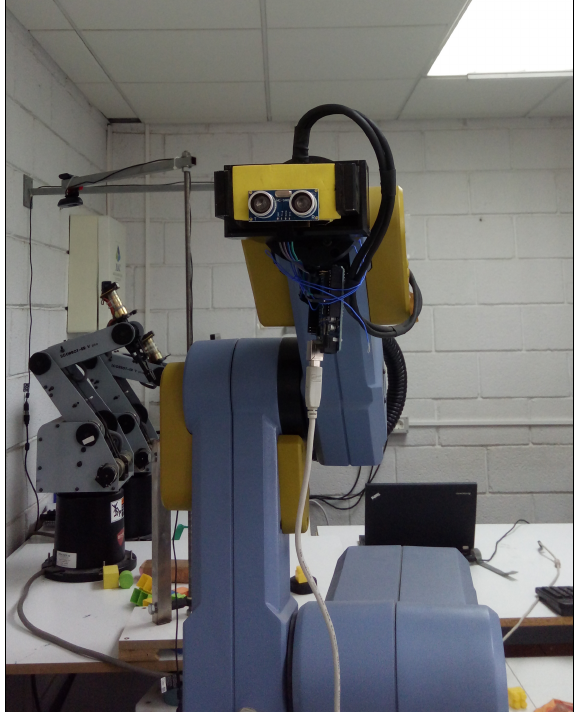
Figure 6. Picture of the laboratory setup to test the aperture of the HC-SR04. Range sensor is mounted in the robotic arm that can rotate the base with high accuracy, leaving the other axis fixed. Data are acquired using an Arduino UNO board (under the sensor) and serial monitor.